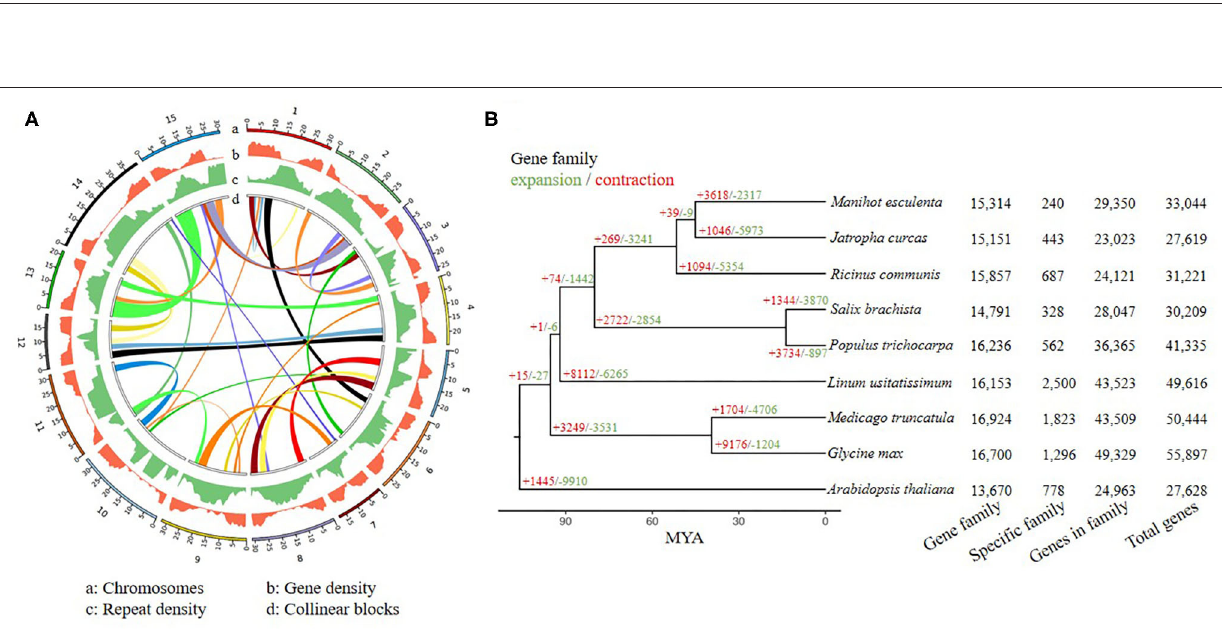
Frontiers in Genetics |